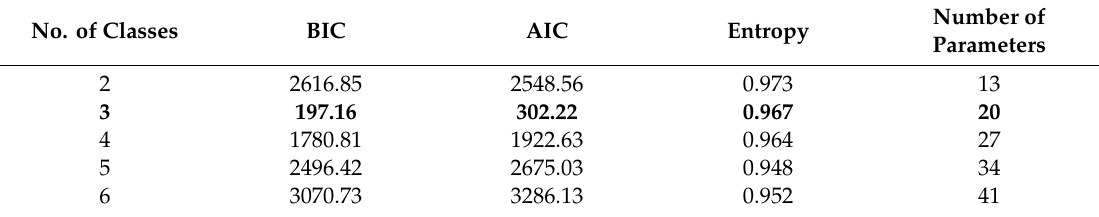
Table 2. Fit indices of the latent class analysis (LCA).